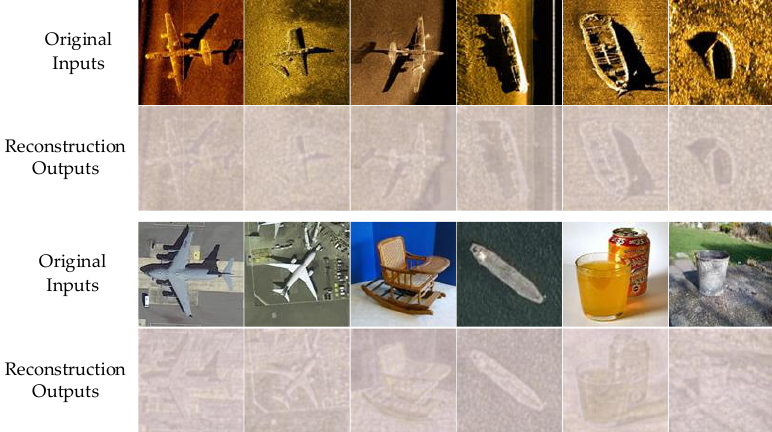
Figure 11. Decoding results of our method, the inputs are the same as those in Figure 6.